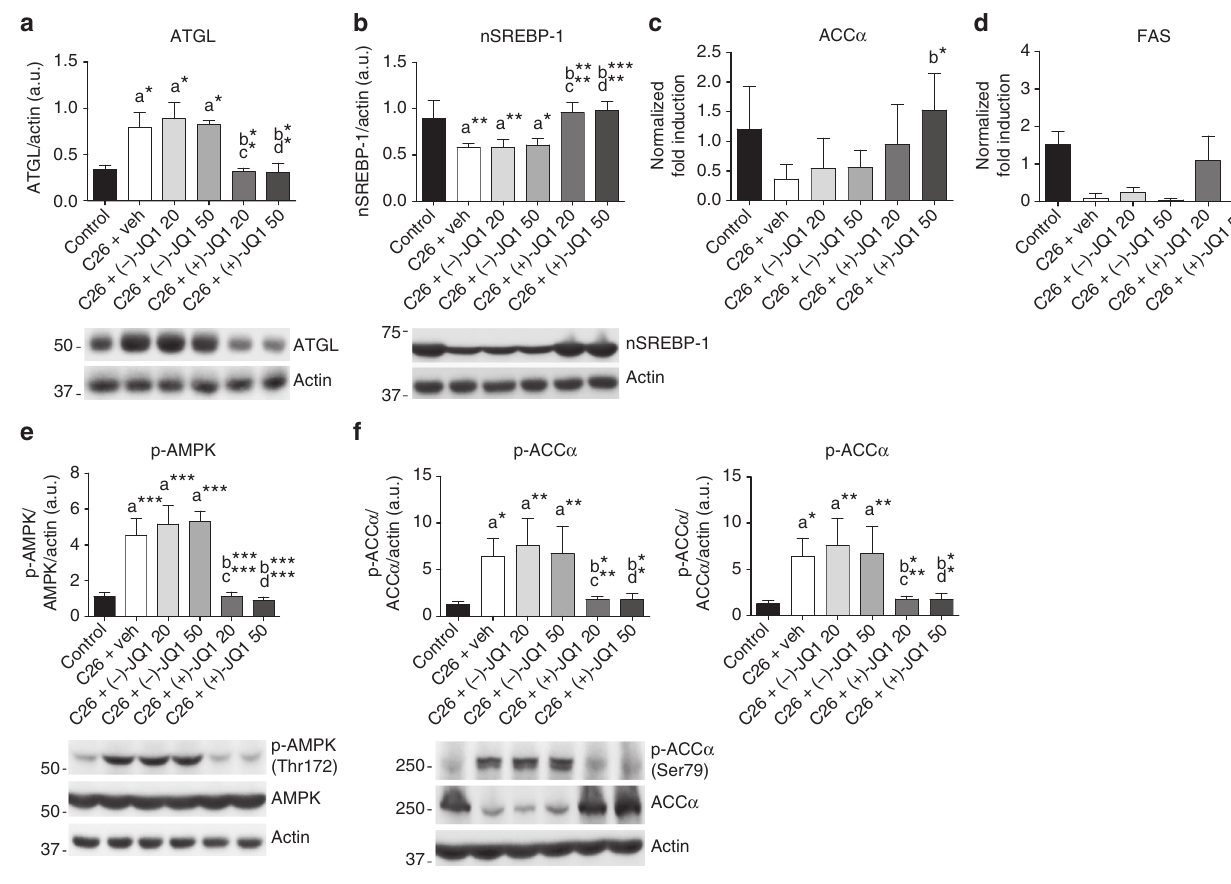
Fig. 8 JQ1 administration blocks epididymal adipose tissue wasting. a Representative western blot and densitometric analysis of ATGL expression in epididymal adipose tissue (eAT) from control animals and C26-tumor-bearing mice treated with vehicle, ( − )-JQ1, and (+)-JQ1 (animals per group: n = 3). Data represent means ± SD. b Representative western blot and densitometric analysis of the nuclear and transcriptionally active fragment of SREBP-1 (nSREBP-1) in the eAT of control and C26-tumor-bearing mice treated with vehicle, ( − )-JQ1, and (+)-JQ1. Four animals were used for each experimental condition. Data represent means ± SD. c , d Total RNA was extracted from eAT of control and C26-tumor-bearing mice (animals per group: n = 5) treated with vehicle or JQ1 ( − /+) and expression levels of ACC α and FAS were measured by quantitative RT-PCR. Data represent means ± SD. e Representative western blot and densitometric analysis of p-AMPK (Thr172) in eAT of the six experimental groups described in a . Four mice were used for each experimental group. Data represent means ± SD. f Representative western blot and densitometric analysis of ACC α protein expression and p-ACC α inhibitory phosphorylation (Ser79) in eAT of control and C26 tumor-bearing mice (animals per group: n = 4) treated with vehicle or JQ1 ( − /+). Data represent means ± SD. Statistical analysis was performed by using one-way ANOVA followed by Tukey ’ s post hoc test. * p < 0.05; ** p < 0.01; *** p < 0.001. “ a ” indicates statistical signi fi cance compared to control; “ b ” indicates statistical signi fi cance compared to C26+ vehicle; “ c ” indicates statistical signi fi cance compared to C26+ ( − )-JQ1 20 mg/kg/day; “ d ” indicates statistical signi fi cance compared to C26+ ( − )-JQ1 50